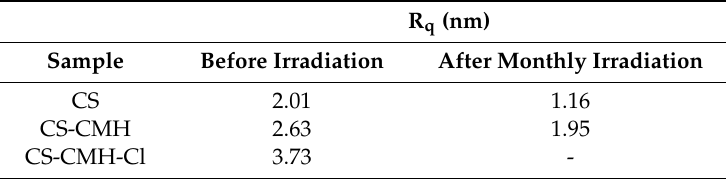
Table 4. Roughness parameter, R q for the obtained chitosan materials for scan area 1 µ m × 1 µ m, before and after